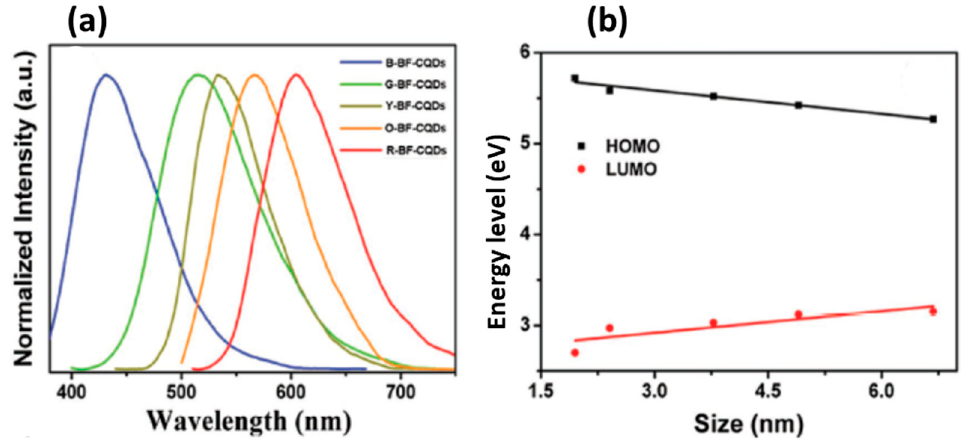
Figure 5. Emission properties of CDs and correlation with size. Panel ( a ) shows the emission of multicolor (blue, green, yellow, orange, and red) bandgap fluorescent (BF) emitting CDs (CQDs). Panel ( b ) reports the dependence of HOMO and LUMO energy level on particle size. Reproduced from [58] with permission of Wiley-VCH, copyright 2016.